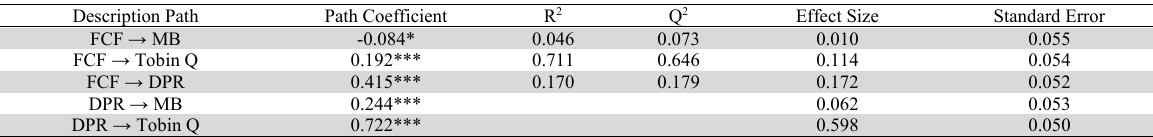
A Result of Structural Model Evaluation